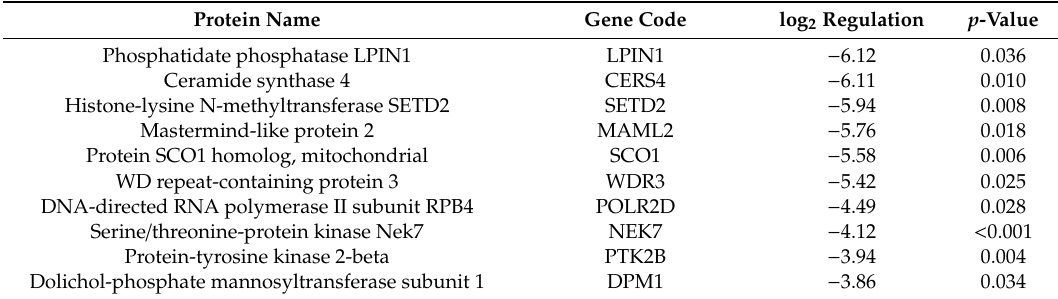
Table 3. Strongest downregulated proteins after CBZ